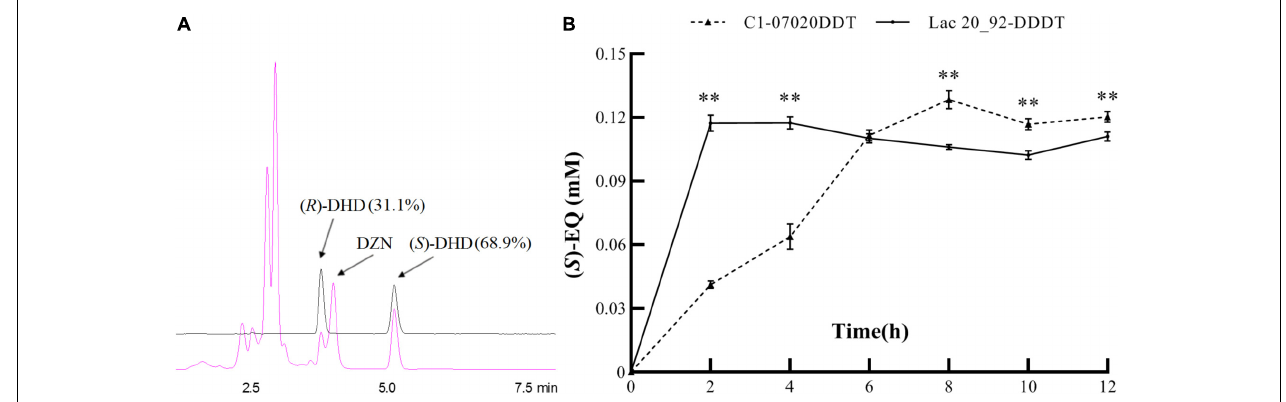
FIGURE 3 | Reductase enzyme activity assays using K-07020. (A) Chiral detection of DHD by HPLC. Standard samples of ( R )- and ( S )-DHD were marked with a black line, and the fermentation sample was marked with a red line; K-07020 recombinant protein can transform DZN to both ( S ) - DHD and ( R ) - DHD. (B) Comparative analysis of (S)-equol production between K-07020DDT and Lac 20_92-DDDT. ∗∗ Represents the P -value less than 0.01 at the same time